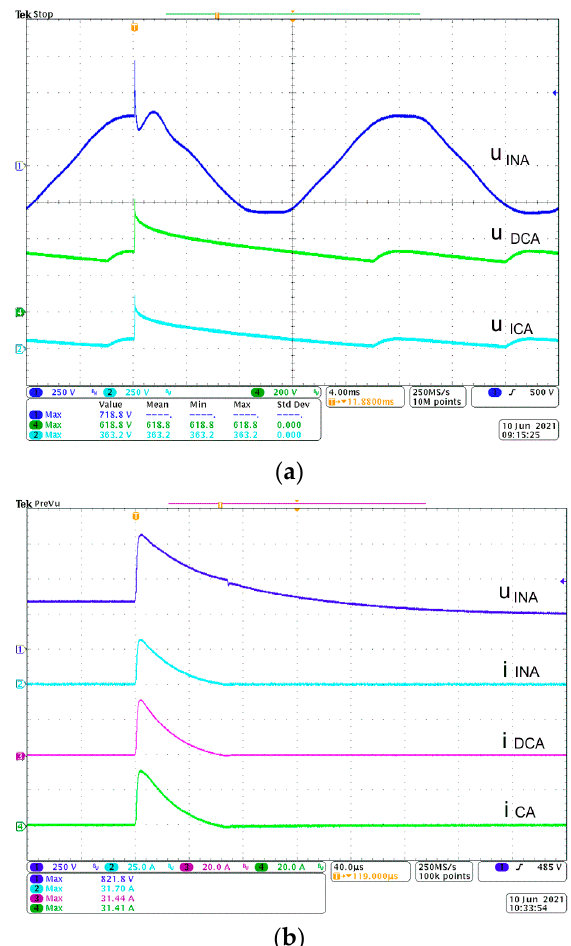
Figure 3. ( a ) Voltage and ( b ) current waveforms at selected test points (marked in Figure 1a) for lamp A for a surge of 1.2/50 µs (8/20 µs) injected at the top of the mains voltage sinusoid.